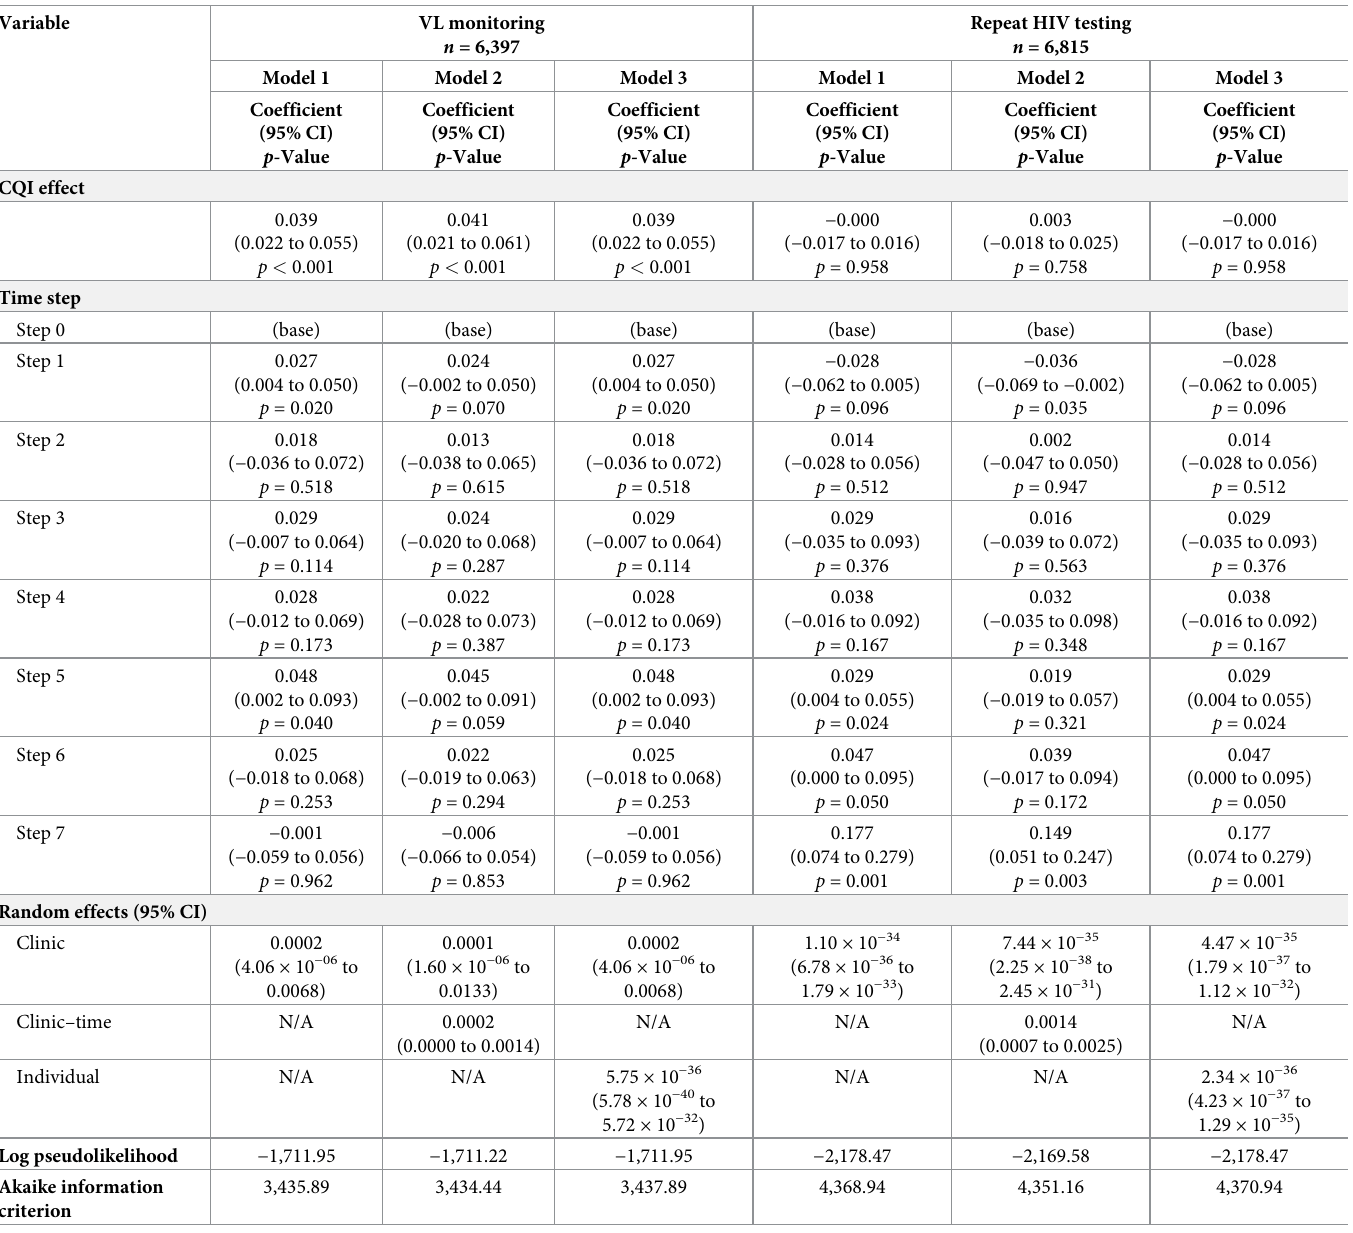
Table 5. Regression models for HIV VL monitoring and repeat HIV testing estimating absolute risk difference.